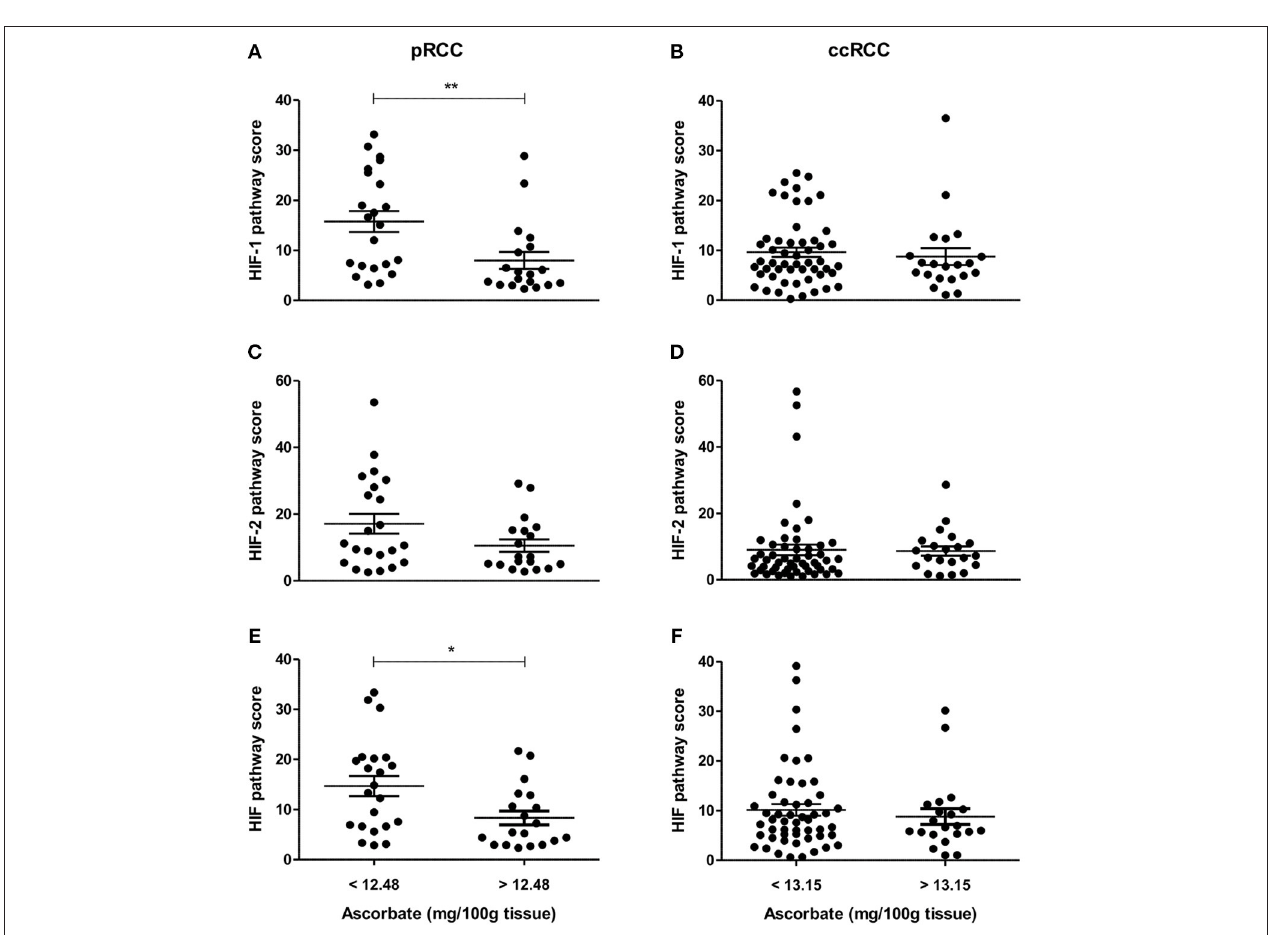
FIGURE 4 | HIF pathway scores of pRCC and ccRCC tumors in relation to tissue ascorbate content. Scatter plots show HIF-1 (A,B) , HIF-2 (C,D), and HIF pathway scores (E,F) of pRCC ( n = 41, left panel) and ccRCC tumors ( n = 73, right panel) divided by the mean ascorbate content. Differences between the groups where evaluated with the Mann-Whitney test. Data represent mean + SEM; * p < 0.05, ** p <